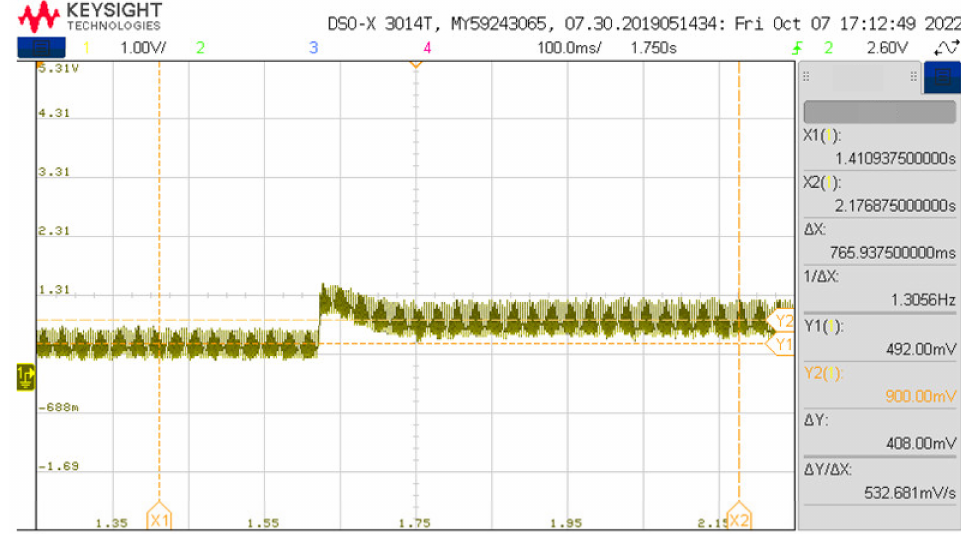
Figure 17. Voltage differential with virtual inertia